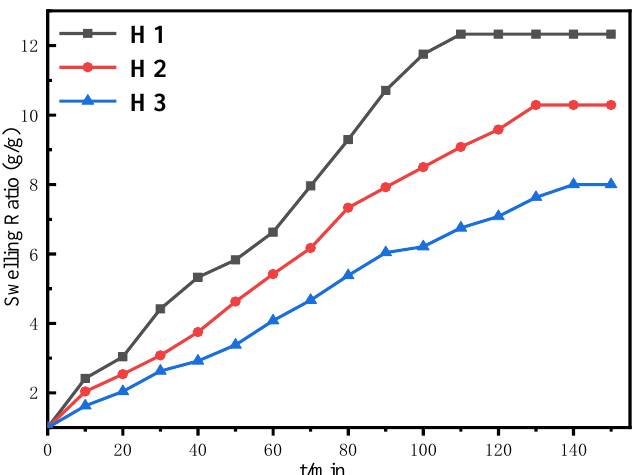
Figure 8. The equilibrium swelling ratio of the supramolecular polymer hydrogels H1 , H2 , and H3 .